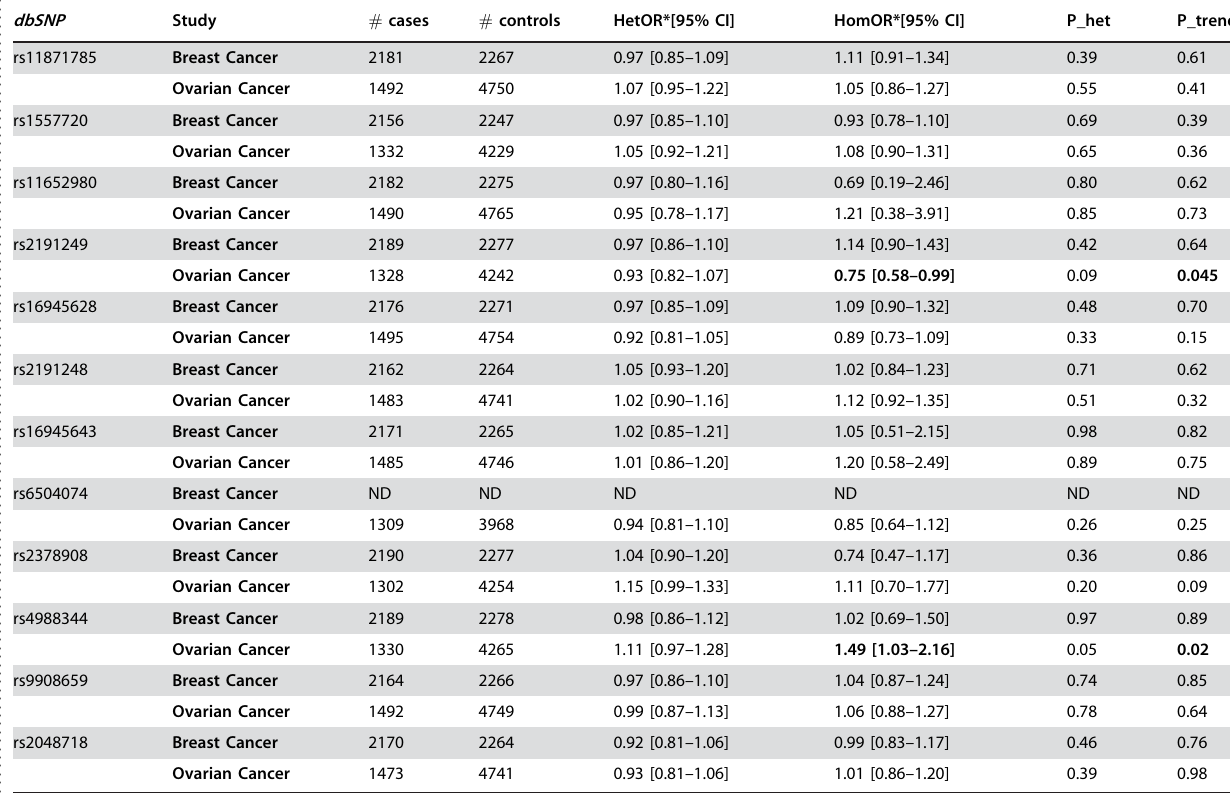
Table 1. Breast and ovarian cancer genotype specific risks for each tSNP by study .. ... .... ... ... .... ... ... .... ... ... .... ... ... .... ... ... .... ... ... .... ... ... .... ... ... .... ... ... .... ... ... .... ... ... .... ... ... .... ... ... .... ... ... .